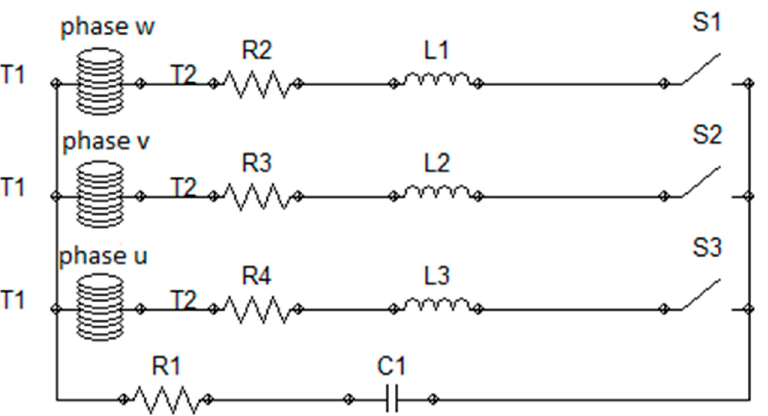
Figure 2. Armature windings connection.